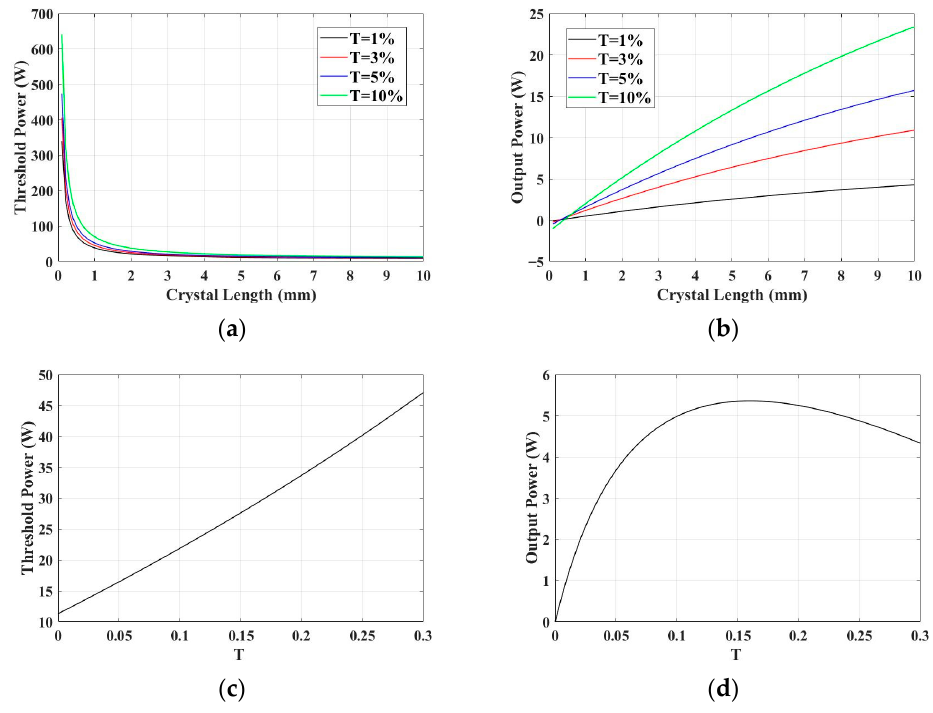
Figure 4. The relationship between ( a ) the threshold pump power and ( b ) the output power of the 1030 nm LG 01 mode vortex laser and the length of the Yb:YAG crystal at a pump power of 20 W; the relationship between ( c ) the threshold pump power and ( d ) output power of the 1030 nm LG 01 mode vortex laser and the output mirror transmittance at a pump power of 20 W and Yb:YAG crystal length of 2 mm.